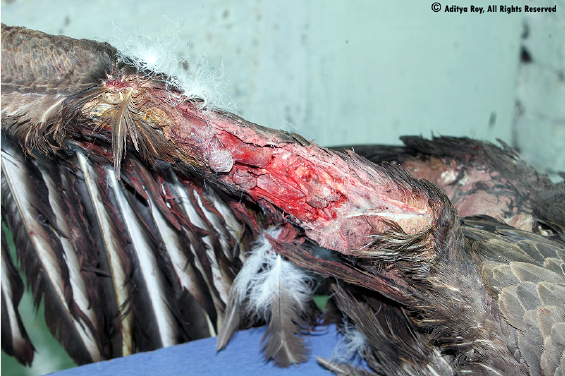
Image 7. Kite string injury in patagium area causing damage to muscle, tendons and